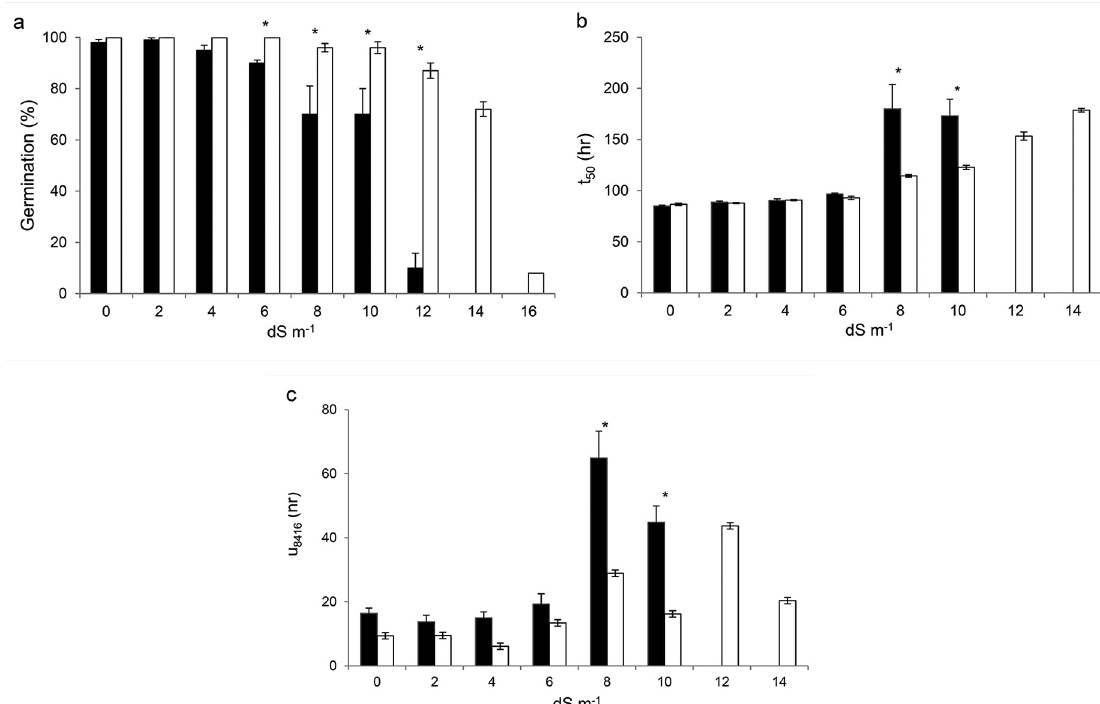
Figure 1 - Germination of non-primed (black bars) and primed seeds (white bars) of P. angulata under saline stress. ( a ) Maximum germination percentage (%); ( b ) Germination rate expressed as time (h) to reach 50% germination (t Germination uniformity expressed as the time (h) interval between 16% and 84% germination of viable seeds (u concentrations expressed as salt electric conductivity from zero (water) up to 16 dS m -1 . All values are means ± SE of 4 replicates of 50 seeds each. Asterisks represent signi fi cant differences between non-primed and primed seeds (Student t-test at P <